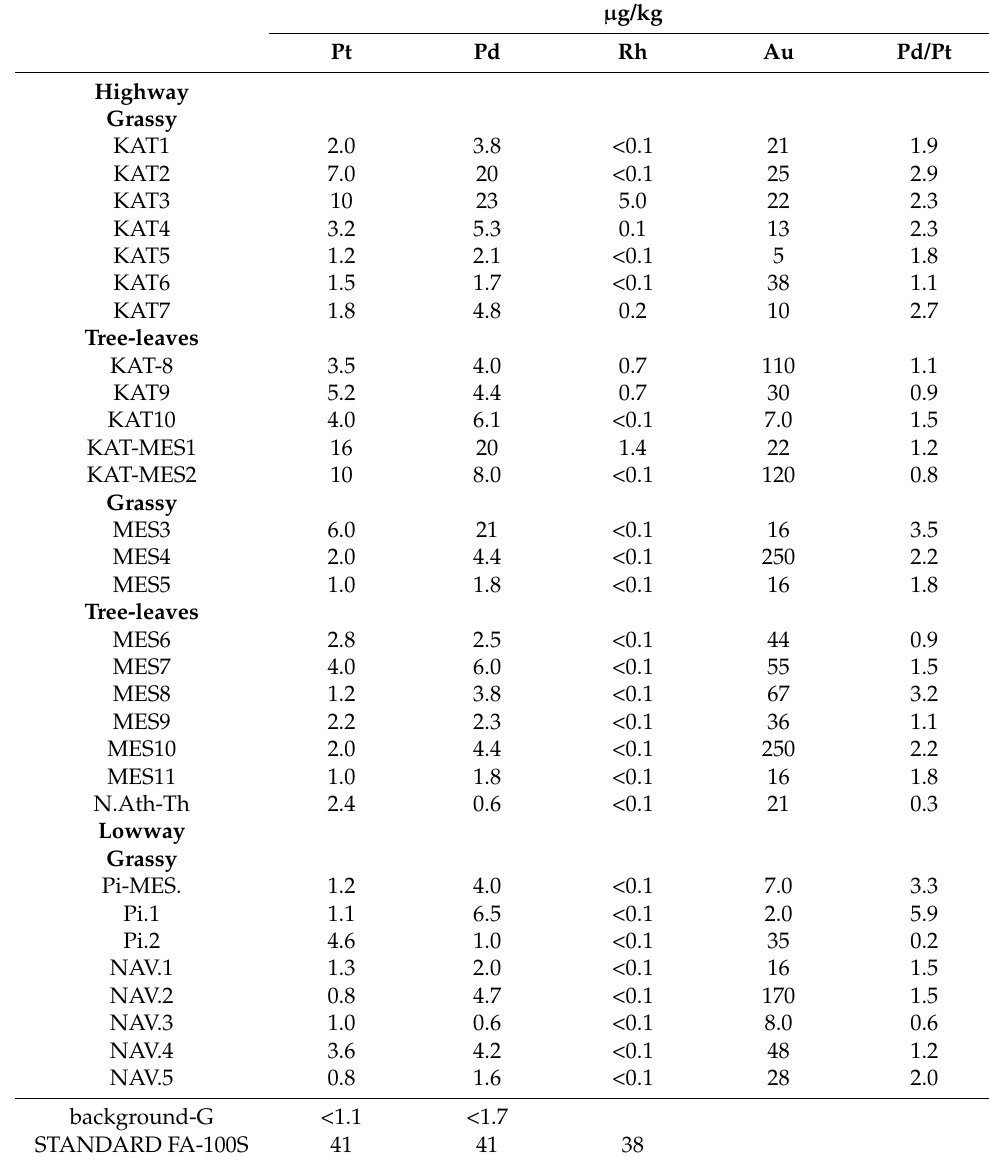
Symbols: As in the Table